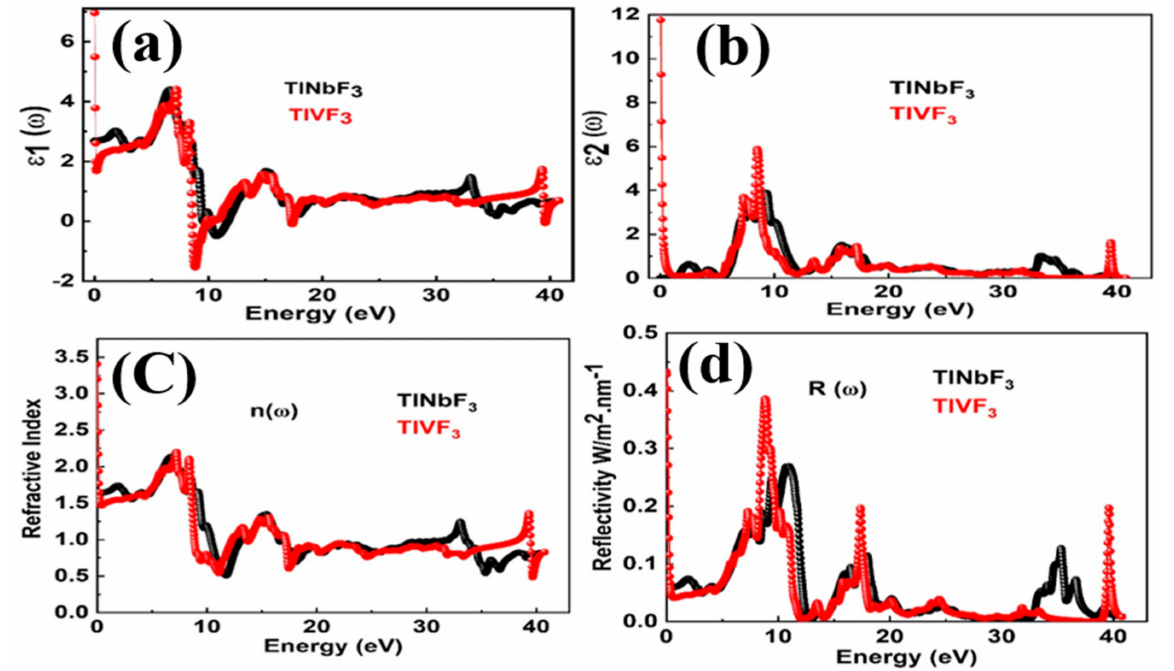
Figure 5. The calculated ε 1 ( ω ) , ε 2 ( ω ) , n( ω ) and R( ω ) of TlVF 3 and TlNbF 3